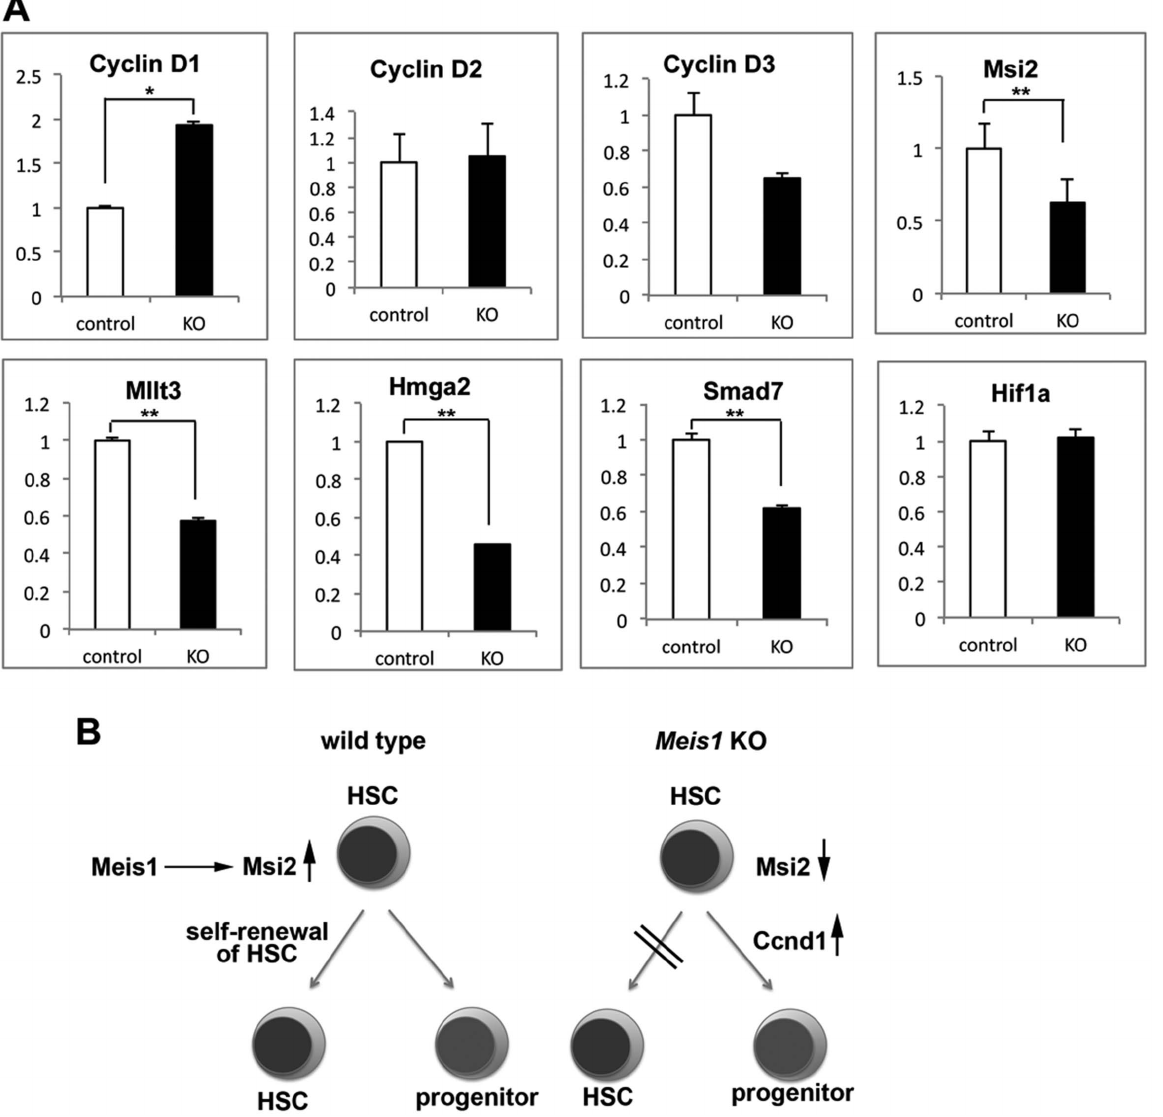
Figure 5. Meis1 controls expression of genes involved in HSC cell cycle and maintenance. (A) Alterations of gene expression in LSK cells induced by Meis1 loss were analyzed by quantitative RT-PCR. Histograms show the indicated transcripts in sorted LSK cells from Mx1-Cre + Meis1 fl/fl mice (open bars) and control Meis1 fl/fl mice (solid bars) one week post poly(I:C) treatment. Data were normalized to Gapdh expression and the level of each transcript in LSK cells from control mice was arbitrarily set to 1. Data are the means and standard deviations of three independent experiments. *p , 0.05 and **p , 0.01. (B) Models illustrating potential mechanisms of Meis1 function in the maintenance of HSC.